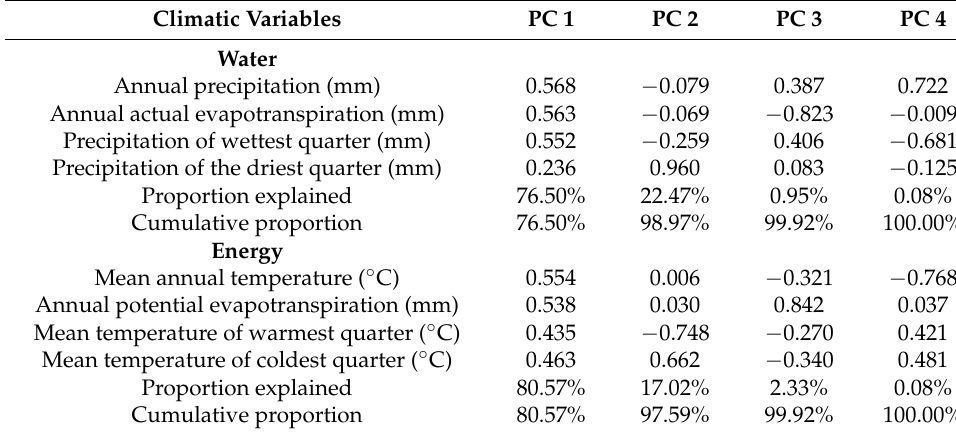
Table 1. The loadings, proportion, and cumulative proportion of the first four principal components for the principal component analysis (PCA) of water and energy predictors. Climatic Variables PC 1 PC 2 PC